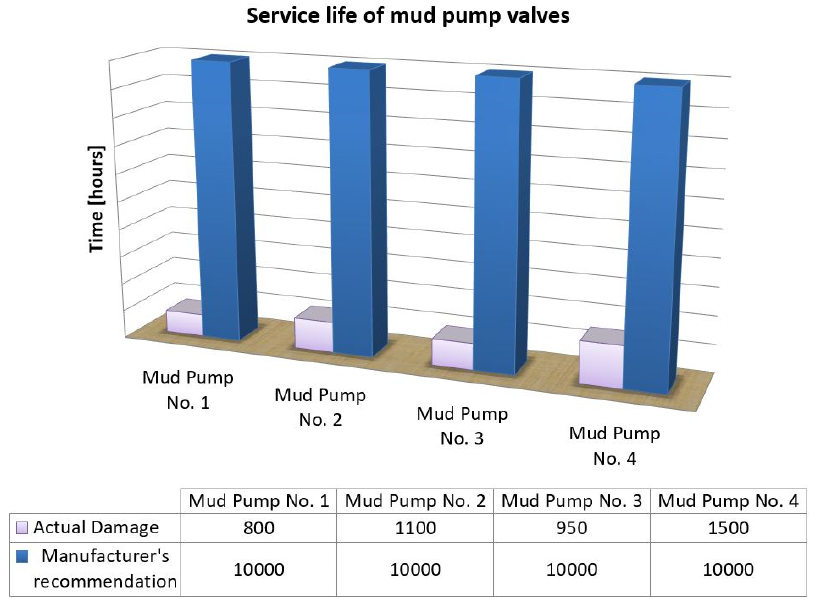
Figure 4. The service life analysis of mud pump valves on drillships [6,7].